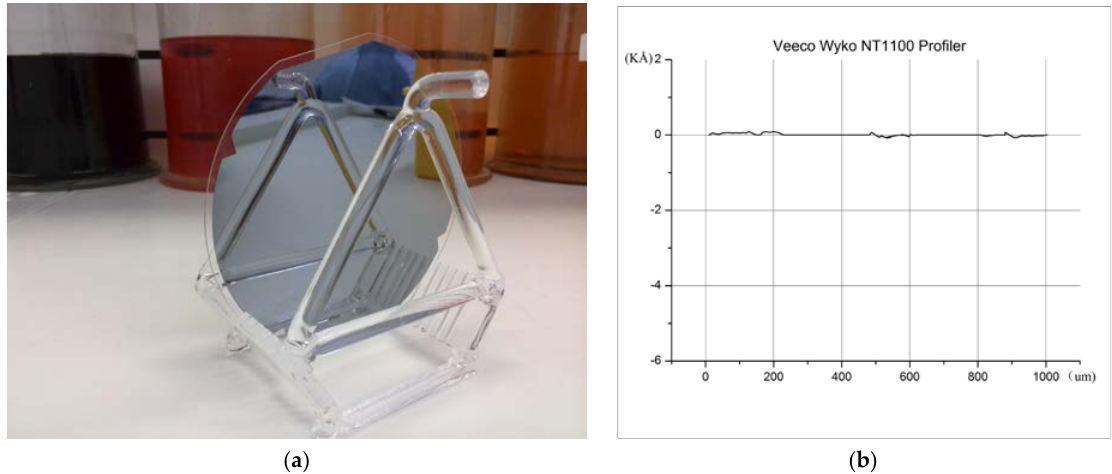
Figure 4. Top view of the final surface quality. ( a ) Final wafers with several test points; ( b ) Measurement of final surface quality